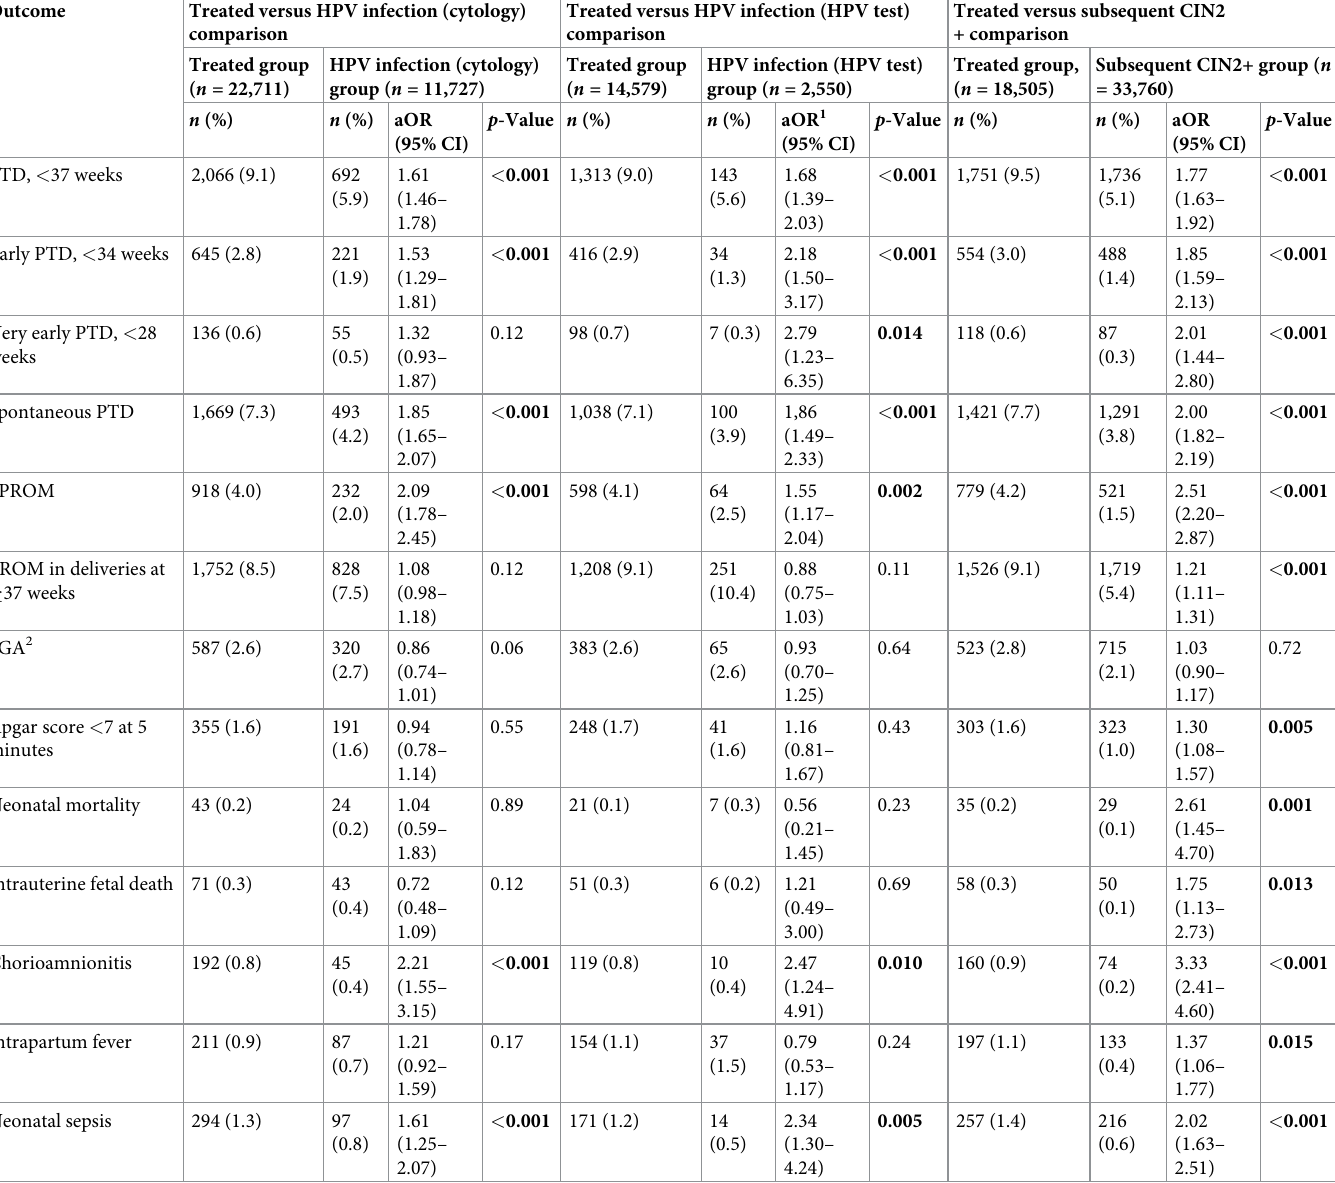
Table 4. Obstetric and neonatal outcomes in the treated group compared to the HPV infection groups and the subsequent CIN2+group—adjusted multivariable logistic regression analyses. AU : Iaddedanotherlevelofcolumnheadstoaddresstheissuethattherewere 3 columnsidenticallylabeledTreatedgroup : Pleasecheckthatthesecolumnheadsarecorrect : .